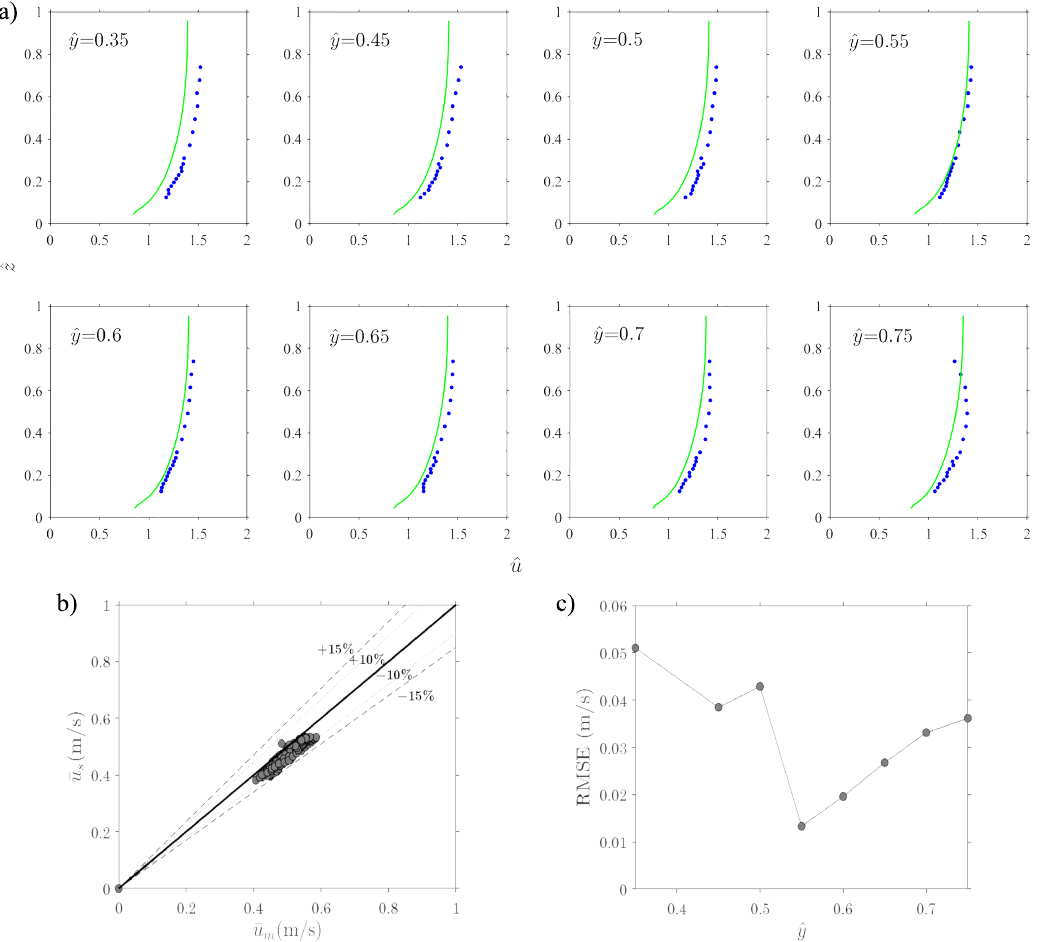
Figure 8. ( a ) comparison of measured (blue dots) and simulated (green lines) non-dimensional streamwise velocity component profiles in cross-section no. 3; ( b ) comparison of measured and simulated streamwise velocity components; ( c ) RMSE of the streamwise velocity component profiles from ˆ y = 0.35 to ˆ y = 0.75 in cross-section no.